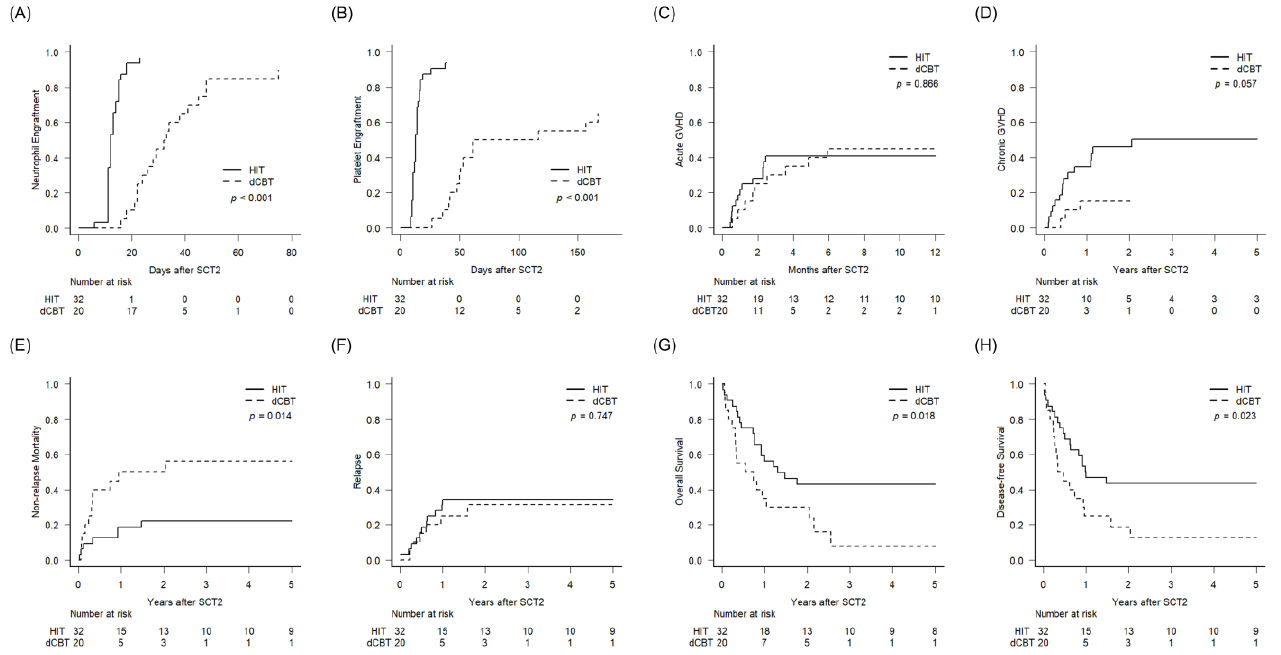
Figure 1. Outcomes after haploidentical and double-cord blood transplantations as the second transplantation. The cumulative incidences of ( A ) neutrophil recovery, ( B ) platelet recovery, ( C ) acute GVHD, ( D ) chronic GVHD, ( E ) non-relapse mortality, ( F ) relapse, and probabilities of ( G ) overall survival and ( H ) disease-free survival.